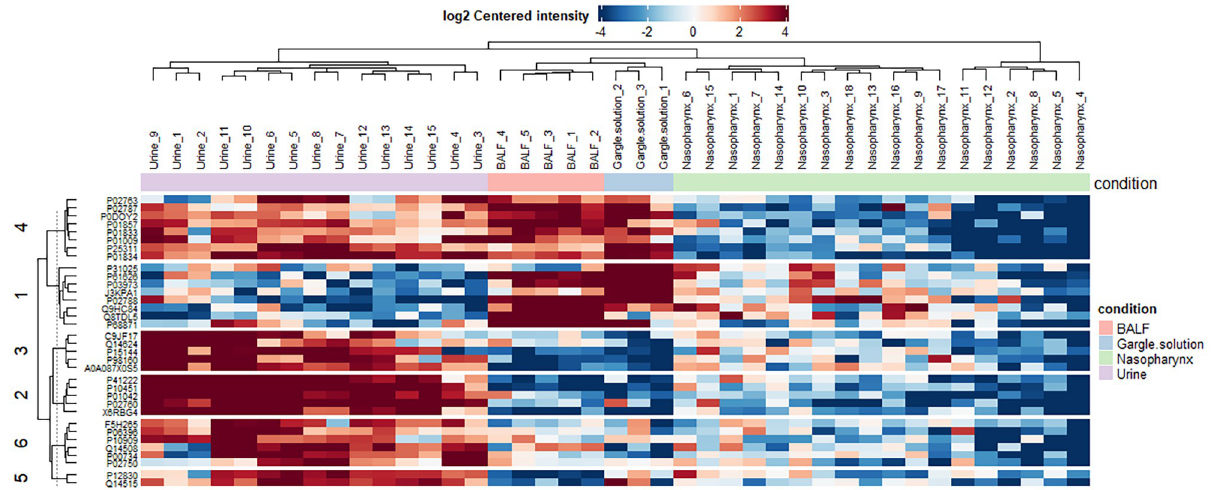
Fig 2. Heatmap showing the protein abundance in urine, bronchoalveolar lavage fluid, gargle solution, and nasopharynx samples we analyzed. The log 2 centered intensity shows the level of protein abundance with “red” representing more abundant proteins and “blue” represents less abundant proteins. The patient groups are shown in the key to the right.